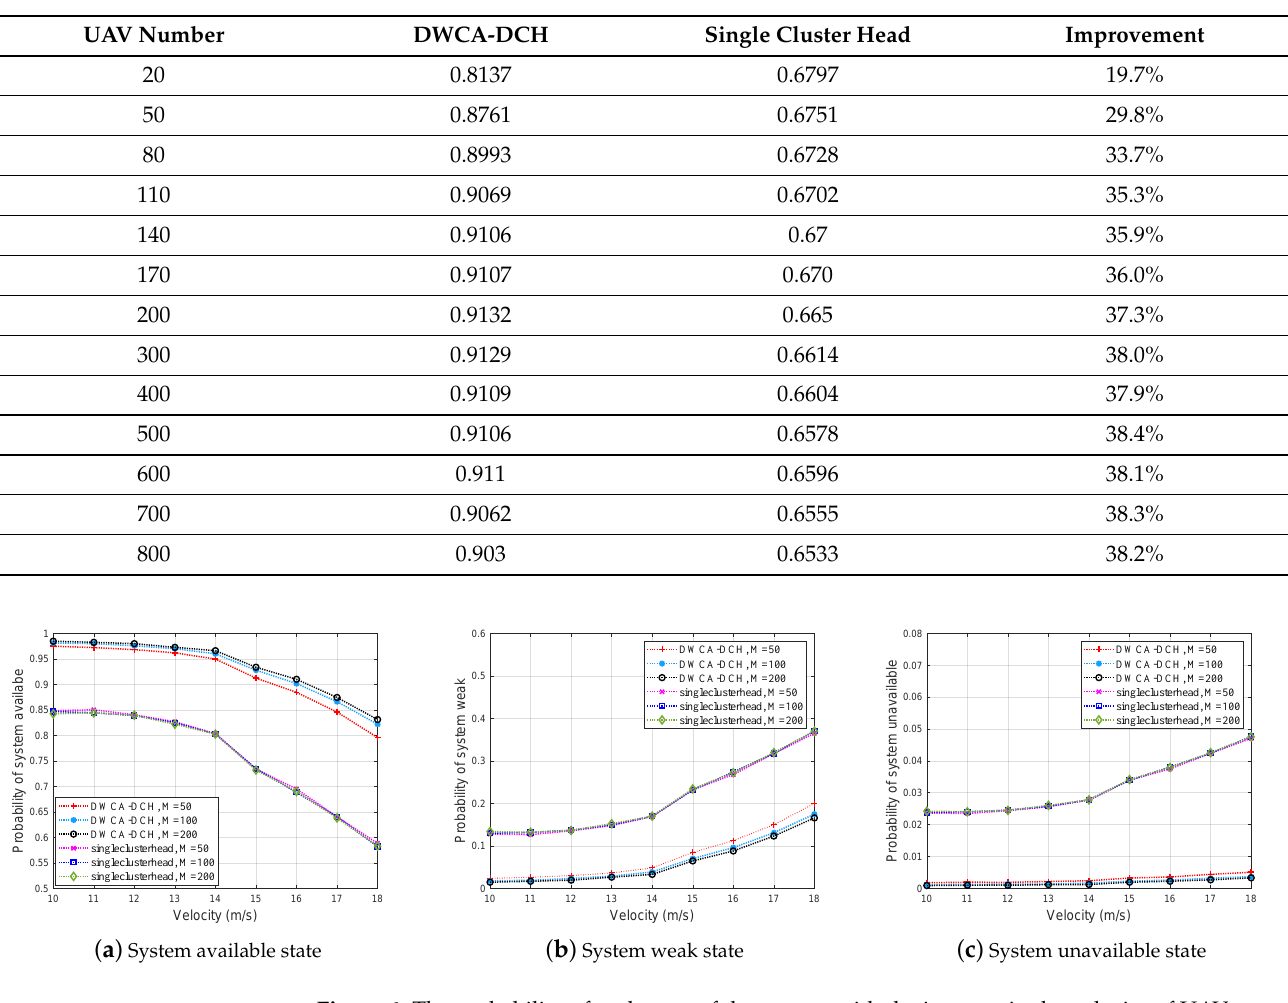
Figure 6. The probability of each state of the system with the increase in the velocity of UAVs. Moreover, along with the increase in λ , the probability of UAV at S state increases. Hence, the system weak probability also increases along with the increase in velocity, which is shown in Figure 6b. Unlike the single cluster head algorithm, the system will transfer into the weak state only when both the pCH and the bCH are in S state or one is in S state and the other is in F state. Consequently, the system weak probability in DCWA-DCH